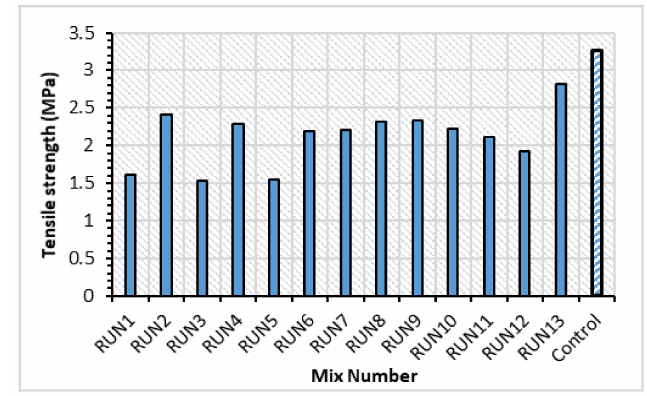
Figure 13. Tensile strength of the HVFA–CRC at 28